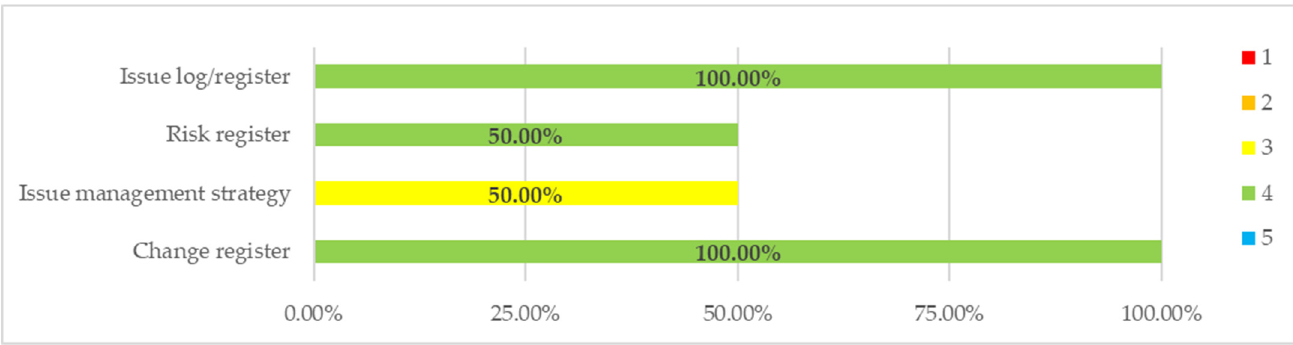
Figure 12. Evaluation of the effectiveness of the methods, techniques and tools used for the integrated change control process. Source: own elab.